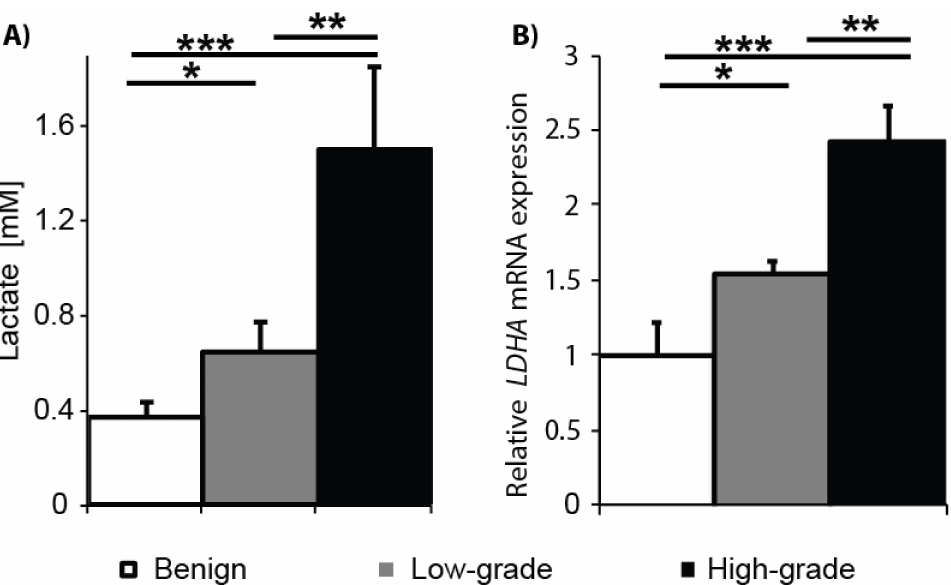
Figure 1. Lactate levels and lactate dehydrogenase A ( LDHA ) mRNA expression are significantly increased in cancer versus benign prostate tissues and in high- versus low-grade cancer. ( A ) Steady state lactate concentration (mM) was measured by 1 HR-MAS in benign biopsies (N = 15), biopsies containing low-grade cancer (N = 11), and biopsies containing high-grade cancer (N = 4); ( B) LDHA mRNA expression was quantified by qRT-PCR in benign, low-grade cancer, and high-grade cancer biopsies (N = 3 each). (* p < 0.05 and > 0.005, ** p < 0.005 and > 0.0005, and *** p <